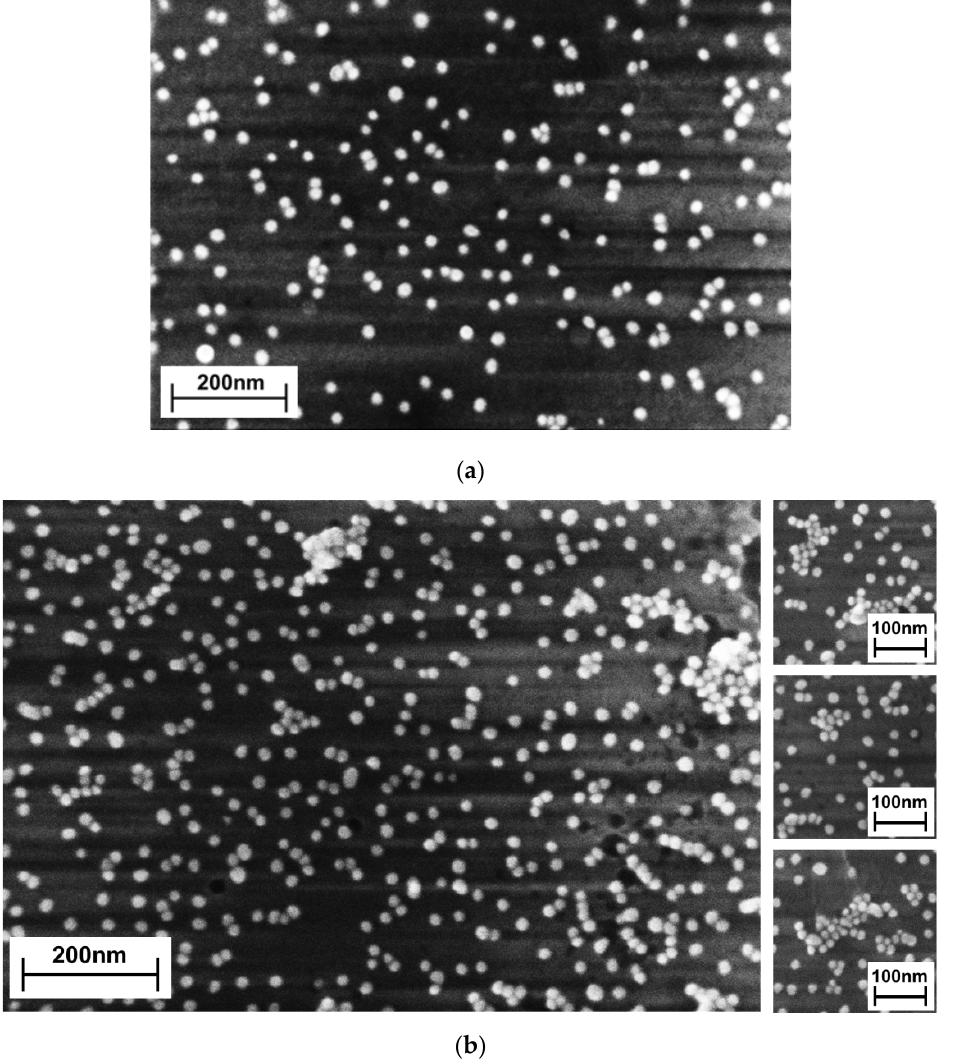
Figure 2. SEM images of ( a ) sample S30 and ( b ) S30 / 20 . The small panels on the right of ( b ) show further areas of sample S30 / 20 with large aggregates.